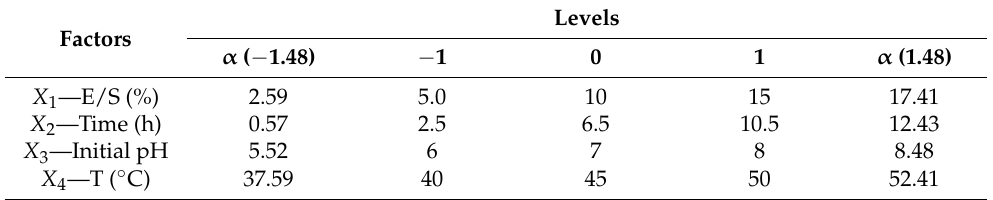
Table 1. Enzymatic hydrolysis variables and respective levels for CCD with Neutrase 0.8 L.